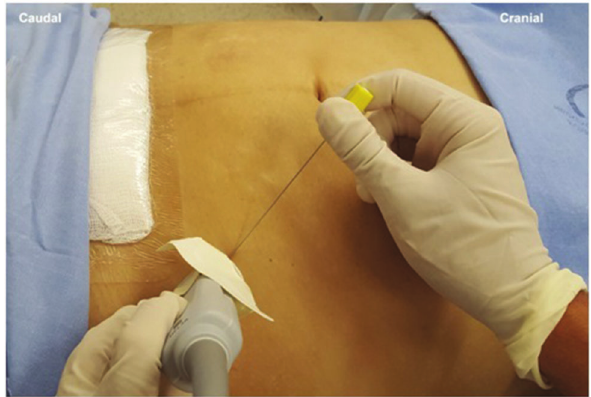
Figure 12 - Probe and needle position for II and IH nerve